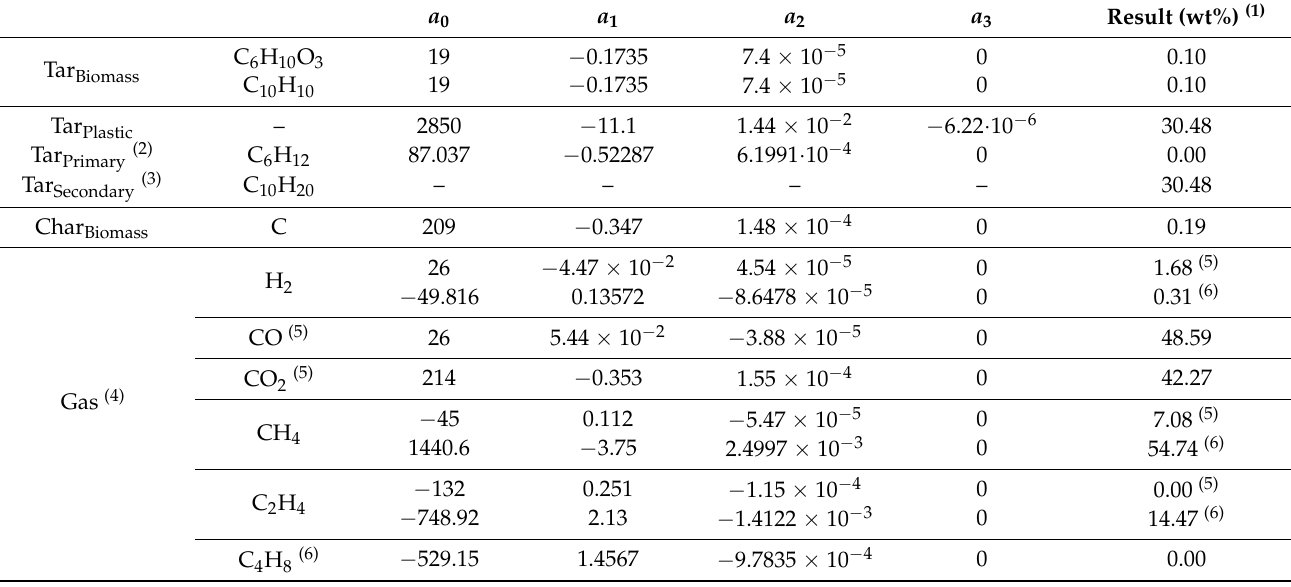
Table 2. Distribution of pyrolysis products.